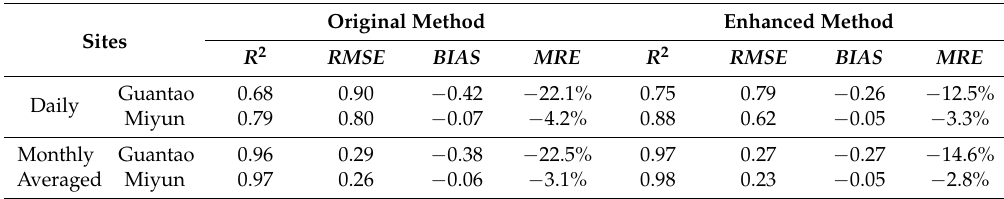
Table 3. Comparison statistics of the daily and monthly averaged ET for both methods at the Guantao and Miyun